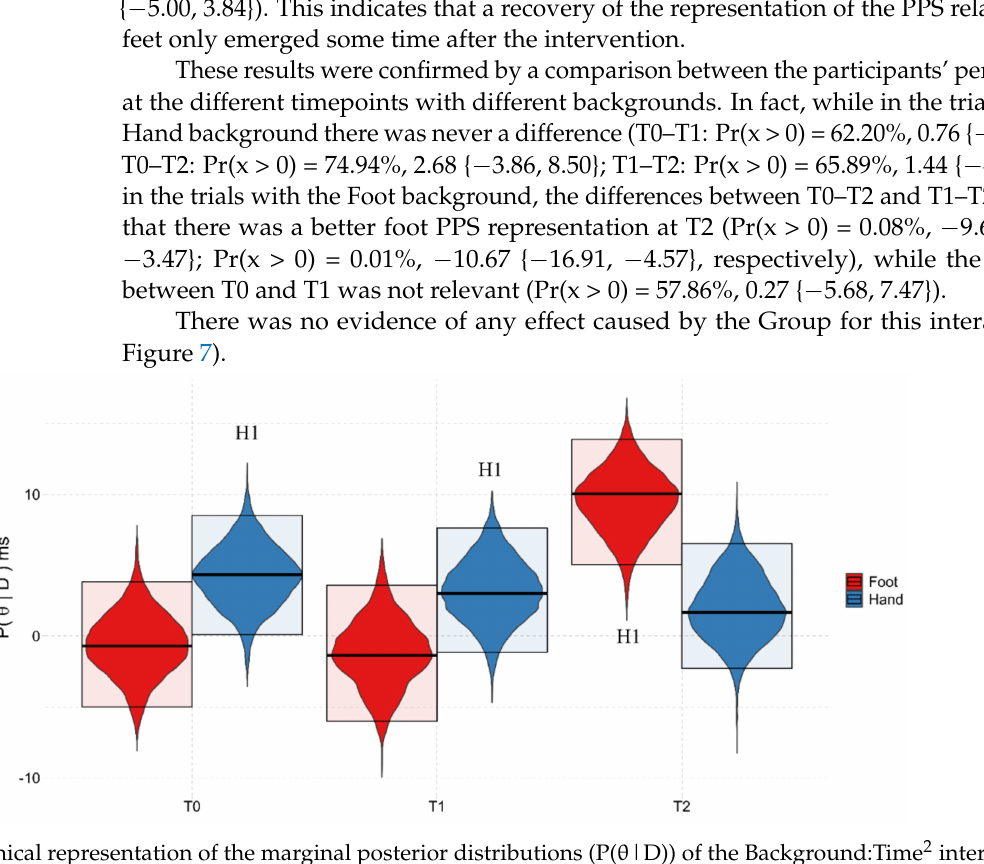
Figure 7. Graphical representation of the marginal posterior distributions (P( θ |D)) of the Background:Time 2 interaction. Description as in Figure 4. H1 = Pr(x > 0) > 83.5%, meaning that the BSE is greater than zero, showing a preserved body representation. T0 = baseline evaluation; T1 = post-training evaluation; T2 = follow-up